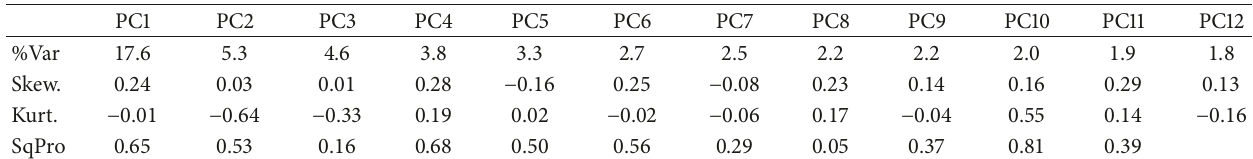
Table 2: % of explained variance, skewness, and kurtosis of the 12 leading PCs and the squared projections of 𝑊 whitened PCs for the analysis over 𝑁 = 11 PCs (see the end of Section 3.2).